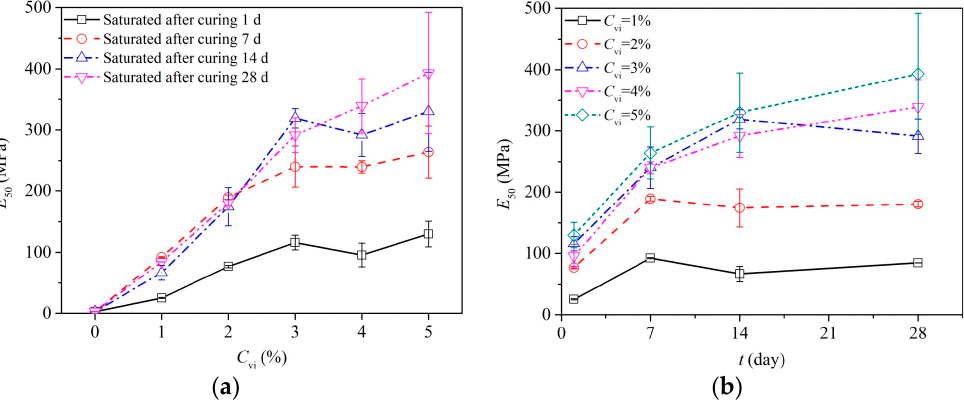
Figure 8. Secant modulus ( E 50 ) of saturated untreated and cement-treated GRSs at various cement contents and curing times. ( a ) Changes in E 50 with cement content at various curing times; ( b ) Changes in E 50 with curing time at various cement contents. ( b ) Changes in E 50 with curing time at various cement contents.